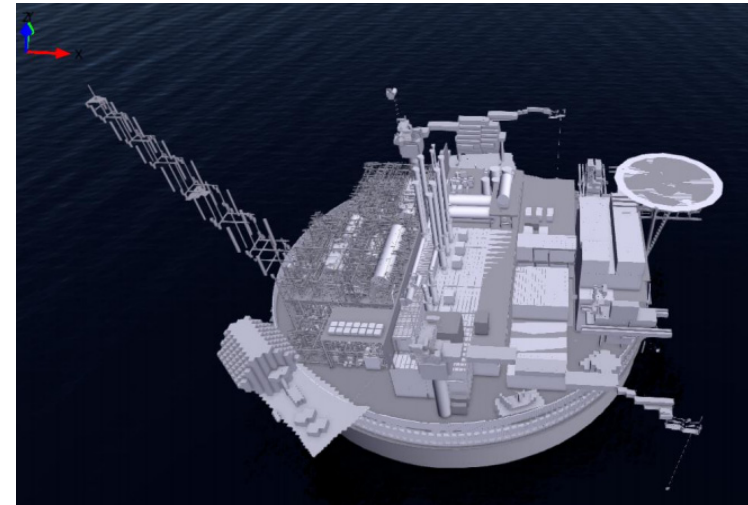
Figure 2. Three-dimensional geometry model of the LH11-1 FPSO.